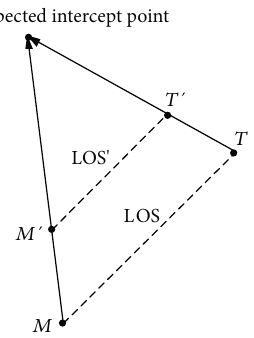
Figure 2: Collision triangle between the missile and the target.